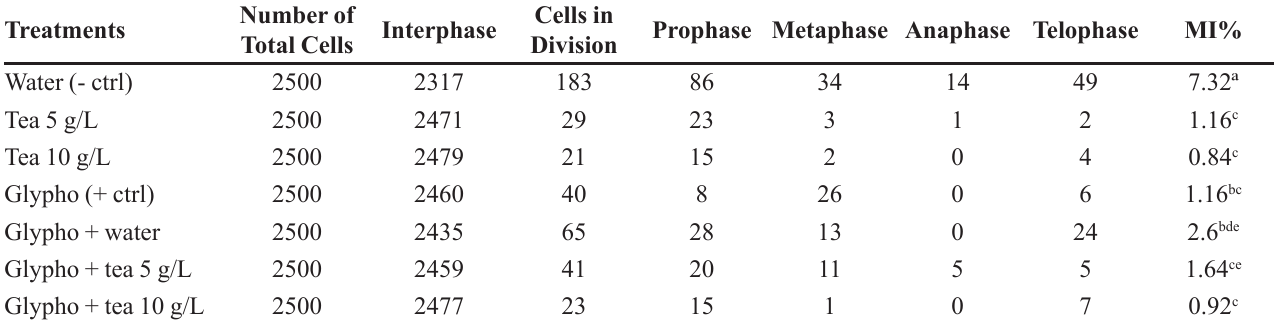
TABLE I – Treatments with number of cells observed in different Allium cepa cell cycles